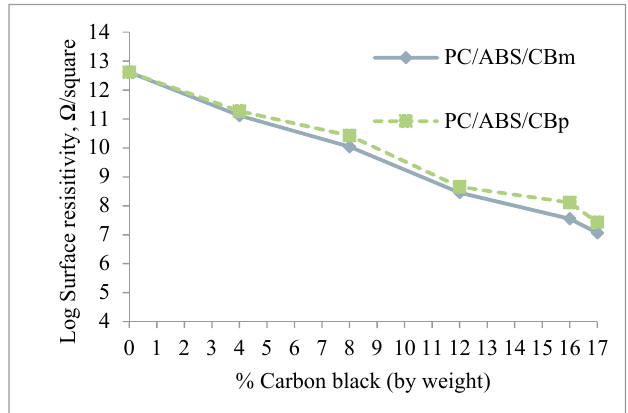
Figure 10. The relationship between surface resistivity and percentage of carbon black.